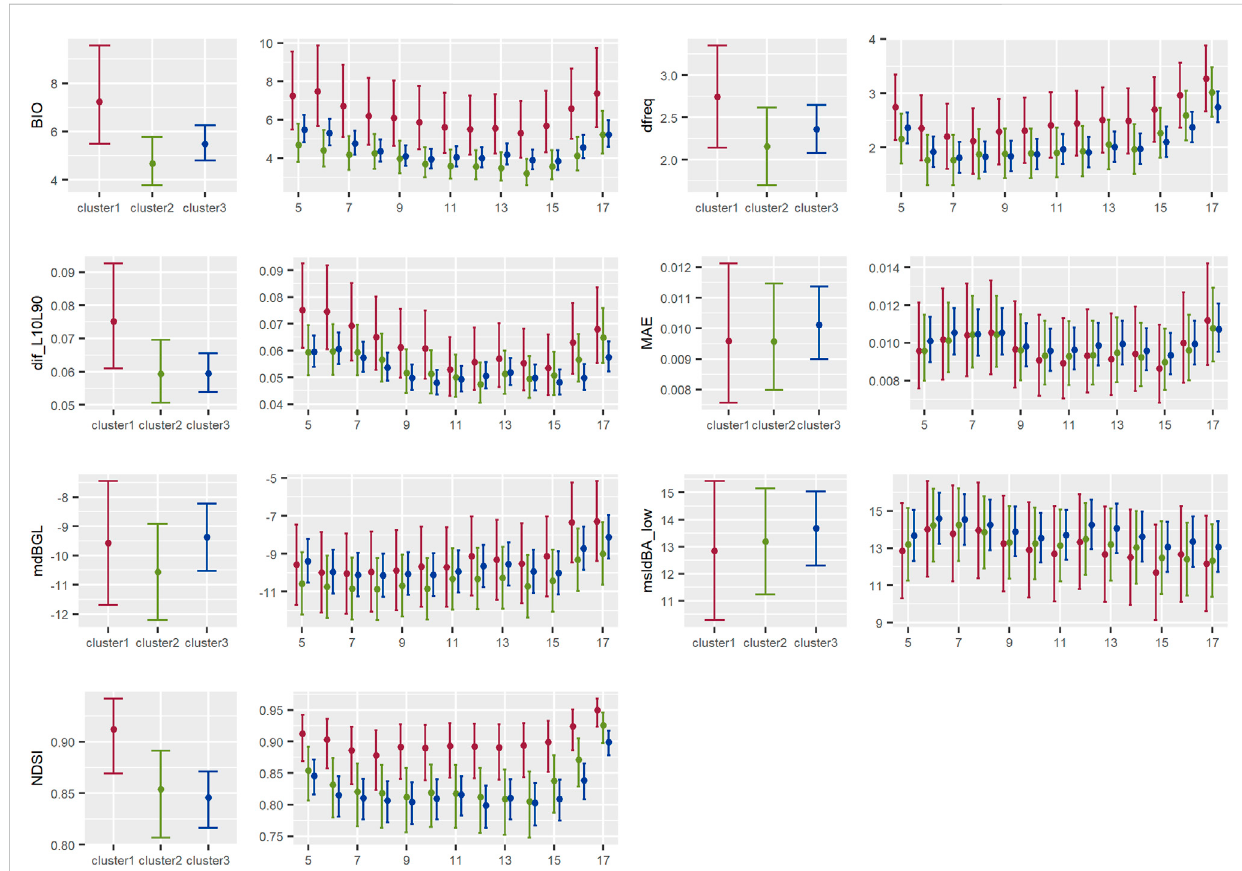
Results of the models showing the contrast between acoustic indices by cluster for the summary of acoustic energy indices type of indices in the Central Conservation Area of Costa Rica, 2019 –